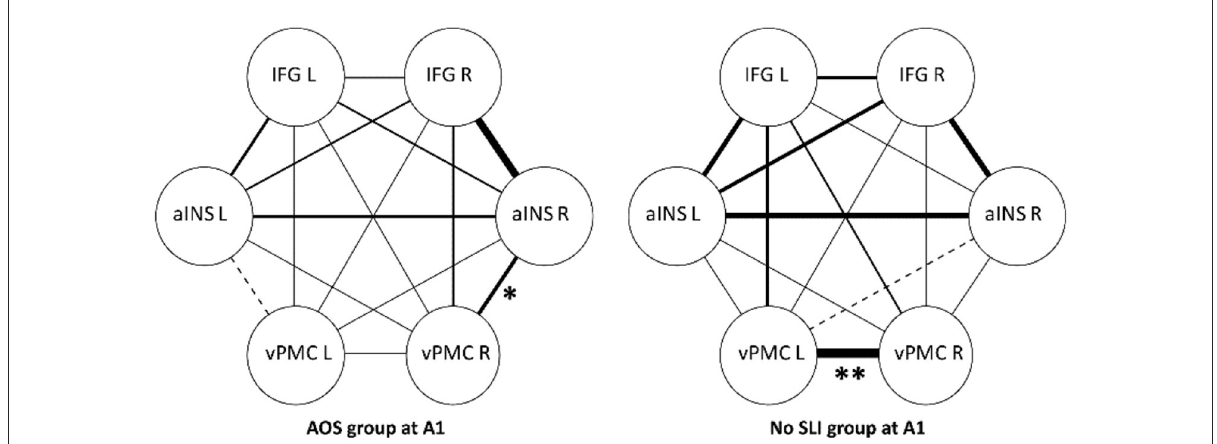
FIGURE2 Functional connectivity strength between ROIs at A1, group comparison. IFG, inferior frontal gyrus; aINS, anterior insula; vPMC, ventral premotor cortex. Significant group differences marked with *( p < 0.05) and **( p < 0.01) in the figure. Line thickness illustrates degree of FC strength.